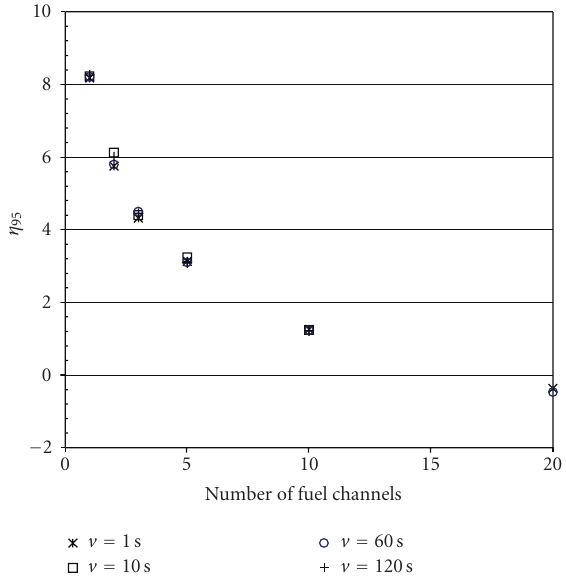
Figure 4: Allowance factor as a function of fuel channels and the transient accident